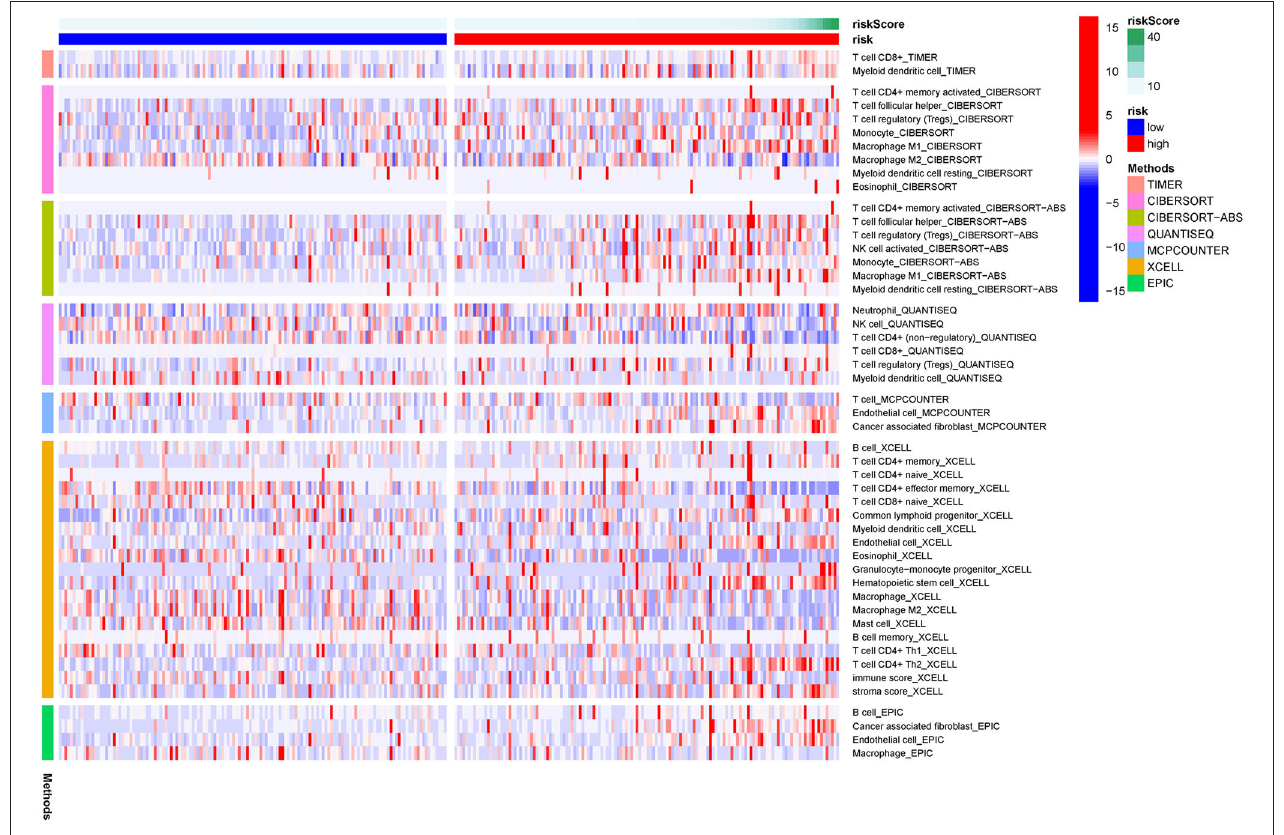
FIGURE 7 | A heatmap of immune responses according to Tumor Immune Estimation Resource (TIMER) algorithms, CIBERSORT, QUANTISEQ, XCELL, MCP counter, and Estimating the Proportion of Immune and Cancer cells (EPIC) between the high- and low-risk pRCC groups.